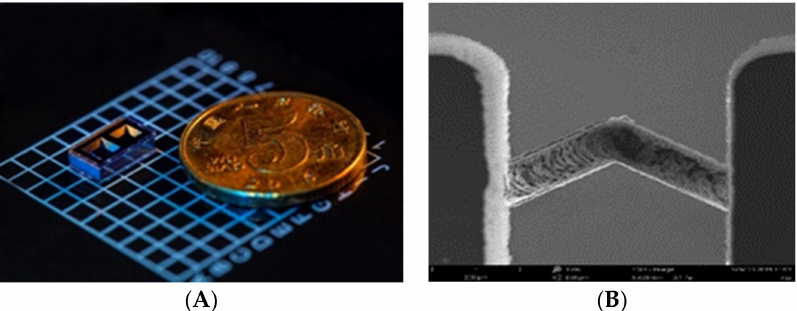
Figure 1. ( A ) Alkali vapor cell and ( B ) SEM image of the channel between the two